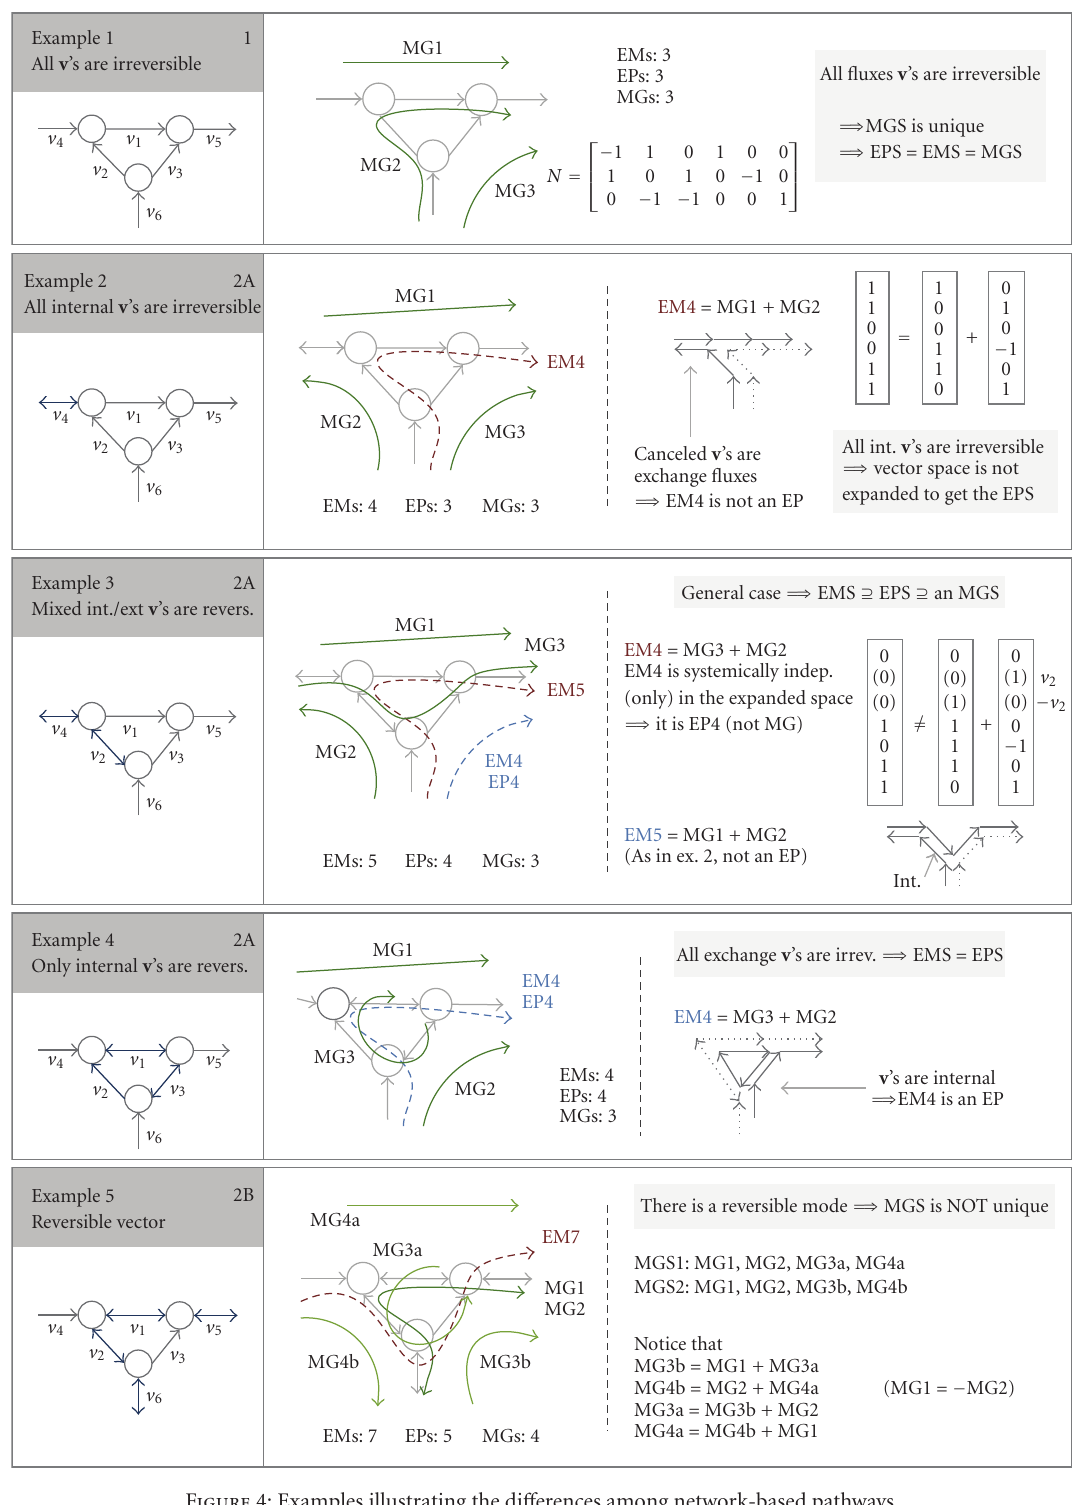
Figure 4: Examples illustrating the di ff erences among network-based